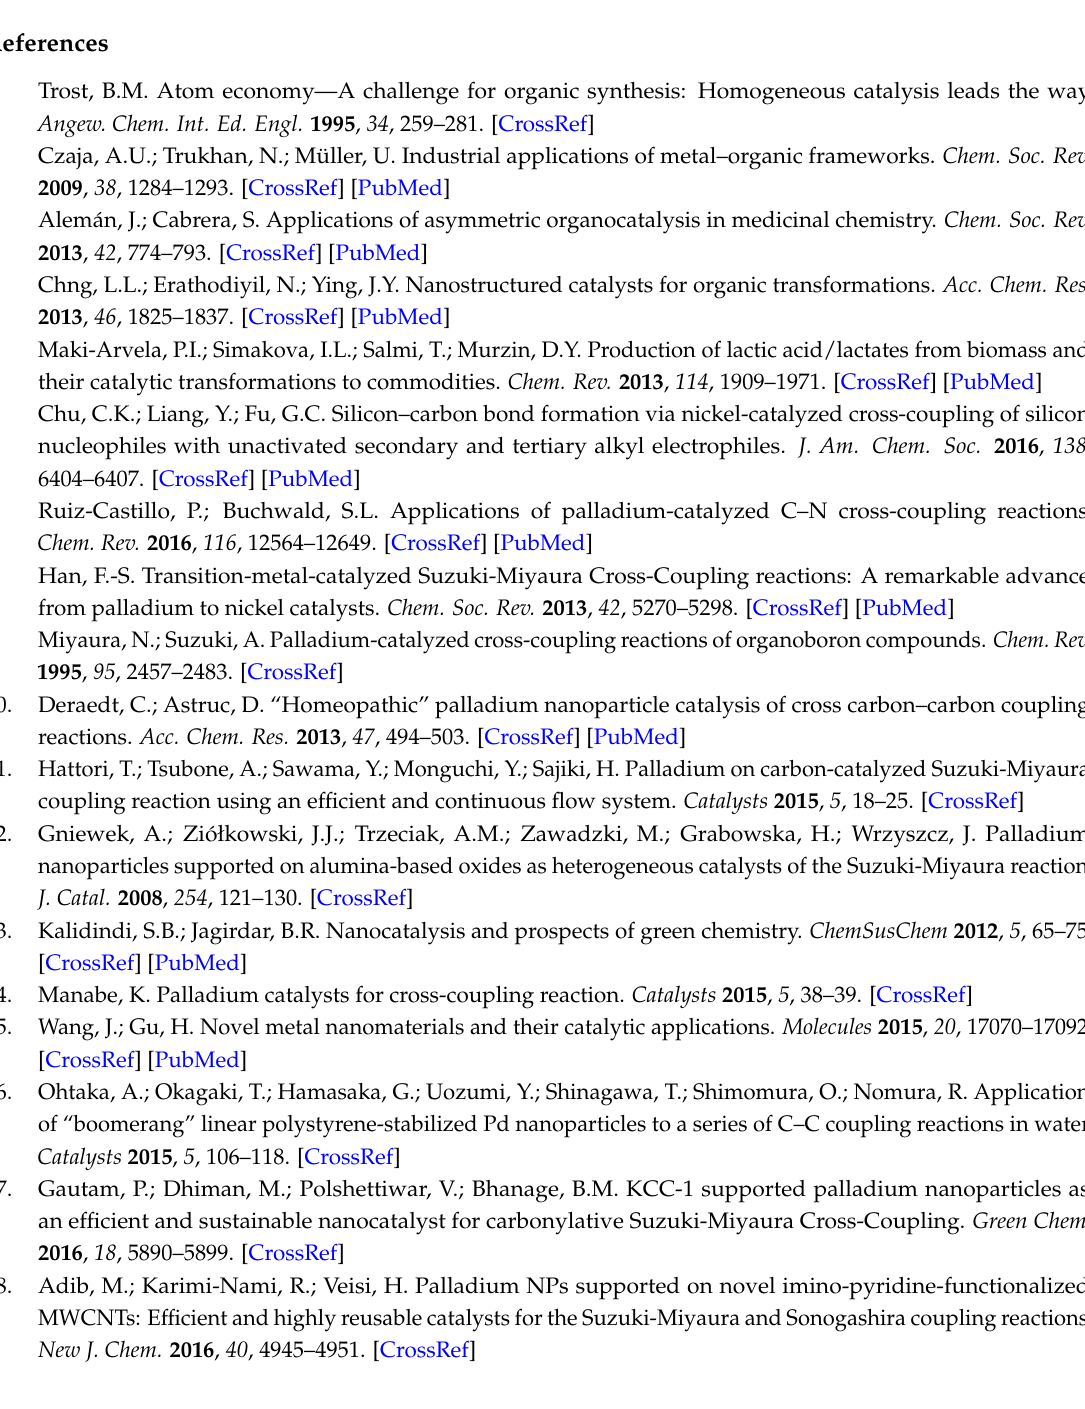
Figure S1: 1 H-NMR spectra of the Suzuki–Miyaura Coupling product. Figure S2: 13 C-NMR spectra of the Suzuki–Miyaura Coupling